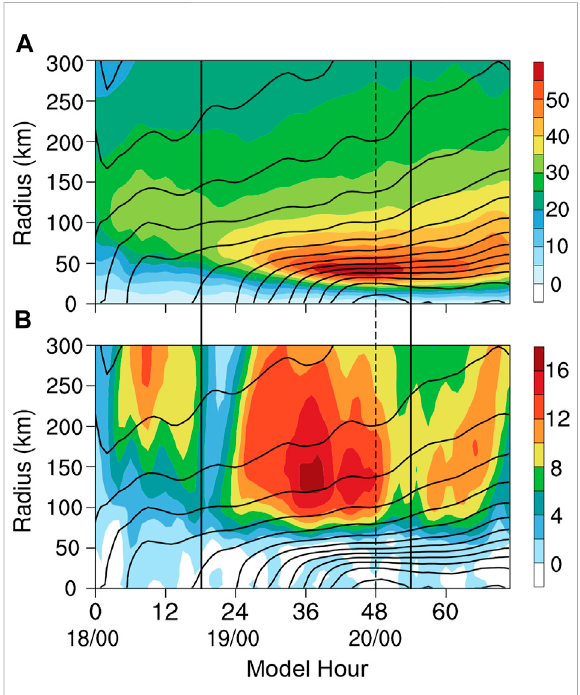
FIGURE 6 Time-radius plots of the azimuthally averaged (A) tangential wind(shadedareas,m s − 1 )at925 hPaand (B) radialwindat125 hPa (shaded areas, m s − 1 ) and the sea level pressure (contours, hPa). The area between the two solid lines denotes the results in the observed RI period, while the dash lines represent the time when Typhoon Roke (2011) reaches its peak intensity in both simulations and